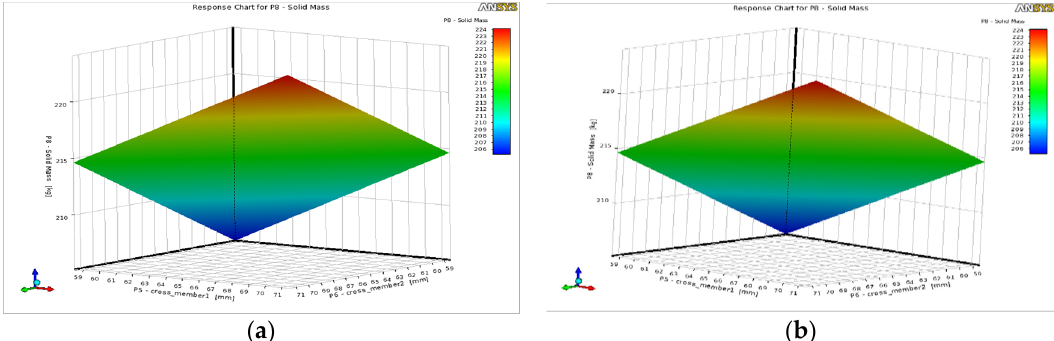
Figure 22. Three-dimensional response surface plot of solid mass ( a ) for CCD scheme ( b ) for optimal space filling design.